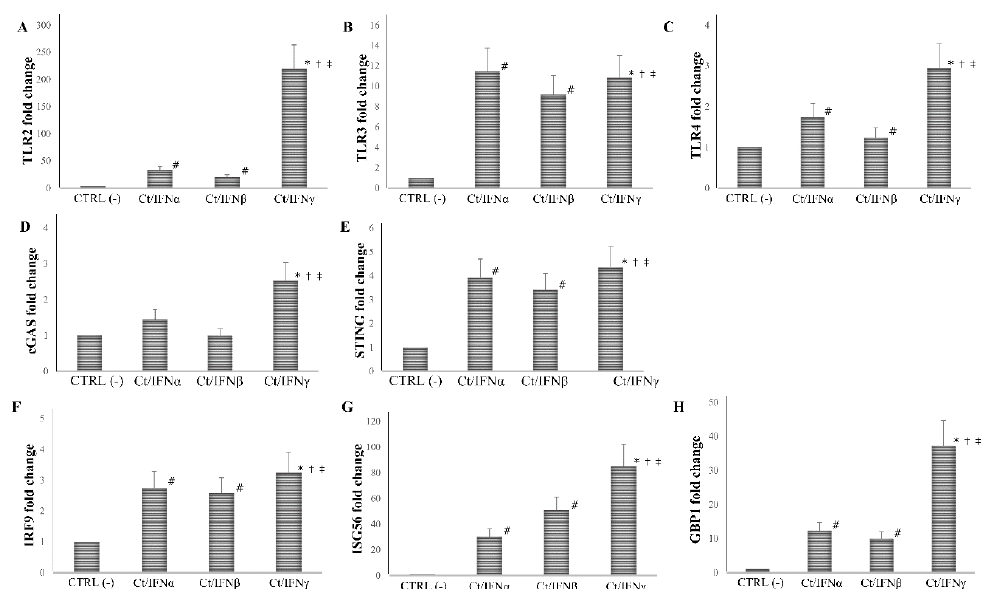
Figure 5. Expression of innate immune response-related genes following the post-infection treatment of C. trachomatis in human synovial fibroblasts. Synovial cells were infected with C. trachomatis and, then, treated with IFN α , IFN β , or IFN γ (10 3 IU / mL) for 24 h. Data are expressed as fold change value (2 − ∆∆ C t method) in mRNA levels compared to baseline values observed in untreated and uninfected synovial cells [set to 1 and indicated in the graphs as CTRL (-)]. Expression of ( A ) TLR2, ( B ) TLR3, ( C ) TLR4, ( D ) cGAS, ( E ) STING, ( F ) IRF9, ( G ) ISG56, and ( H ) GBP1. * p < 0.01 vs. CTRL (-); # p < 0.05 vs. CTRL (-); † p < 0.05 vs. Ct / IFN α ; ‡ p < 0.05 vs. Ct / IFN β